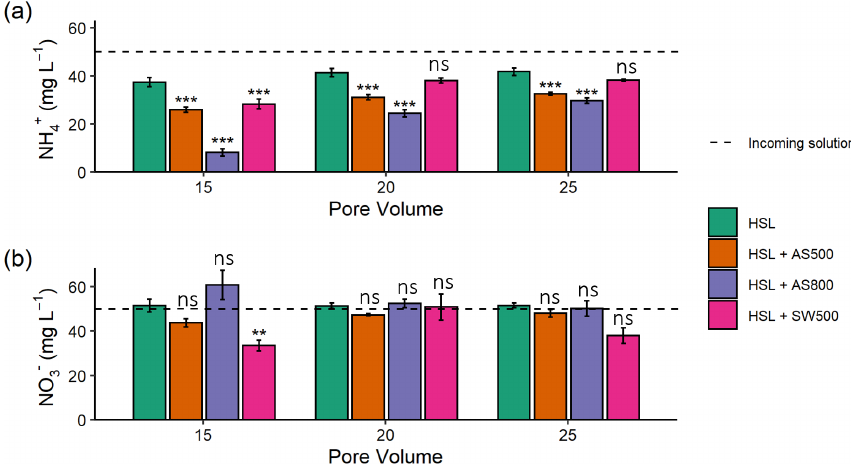
Figure 5. Quantity of (a) ammonium and (b) nitrate in Hanford Sandy Loam (HSL) soil columns with 0% and 2% additions of AS500, AS800, and SW500 biochars in pore volumes 15, 20, and 25 ( n = 5). Error bars represent standard error of the means. Symbols denote significance levels as follows: n.s.: not significant, ∗ p < 0 . 05, ∗∗ p < 0 . 01, and ∗∗∗ p < 0 . 001. P values refer to comparisons between treatments and the control within each pore volume and were corrected for multiple comparisons using Tukey’s HSD method.